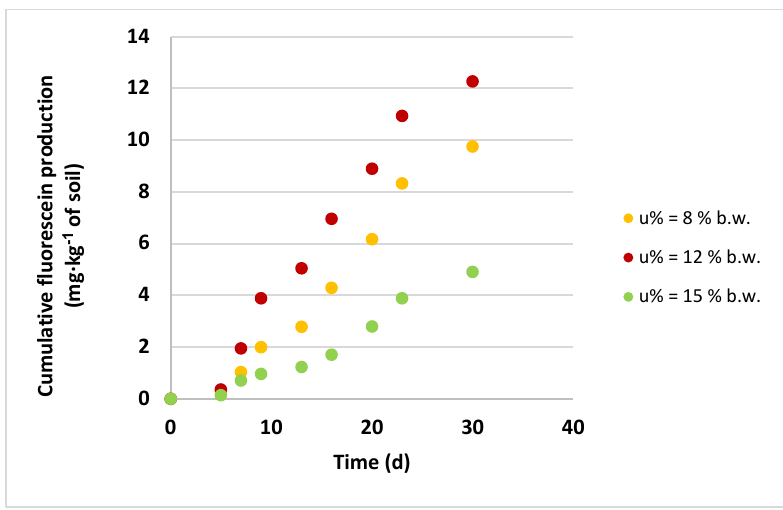
Figure 2. Cumulative fluorescein production by microcosms with C/N = 120.